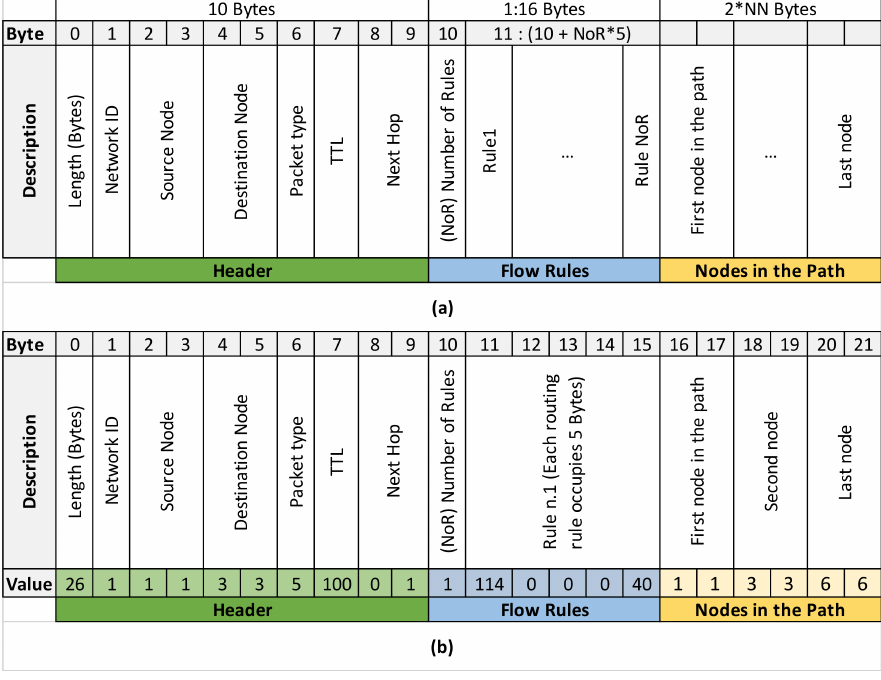
Figure 2. Structure of the original OpenPath packet. ( a ) Generic example, ( b ) example with three- node Route and one Flow